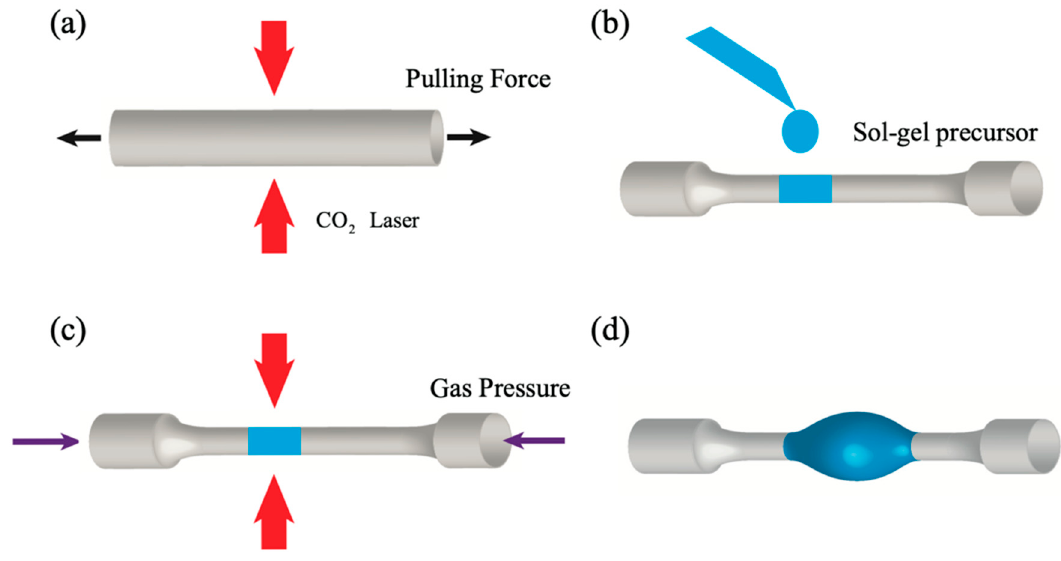
Figure 12. Fabrication process of a sol–gel-coated microbubble resonator using CO 2 laser heating. ( a ) A capillary is tapered using CO 2 laser heating and a pulling force. ( b ) Erbium-doped sol–gel precursor is drop-coated onto the tapered capillary. ( c ) Air pressure is applied inside the capillary while heating it by CO 2 laser. ( d ) A sol–gel-coated microbubble is formed. Reproduced with permis- sion from [93], copyright 2017, The Optical Society.